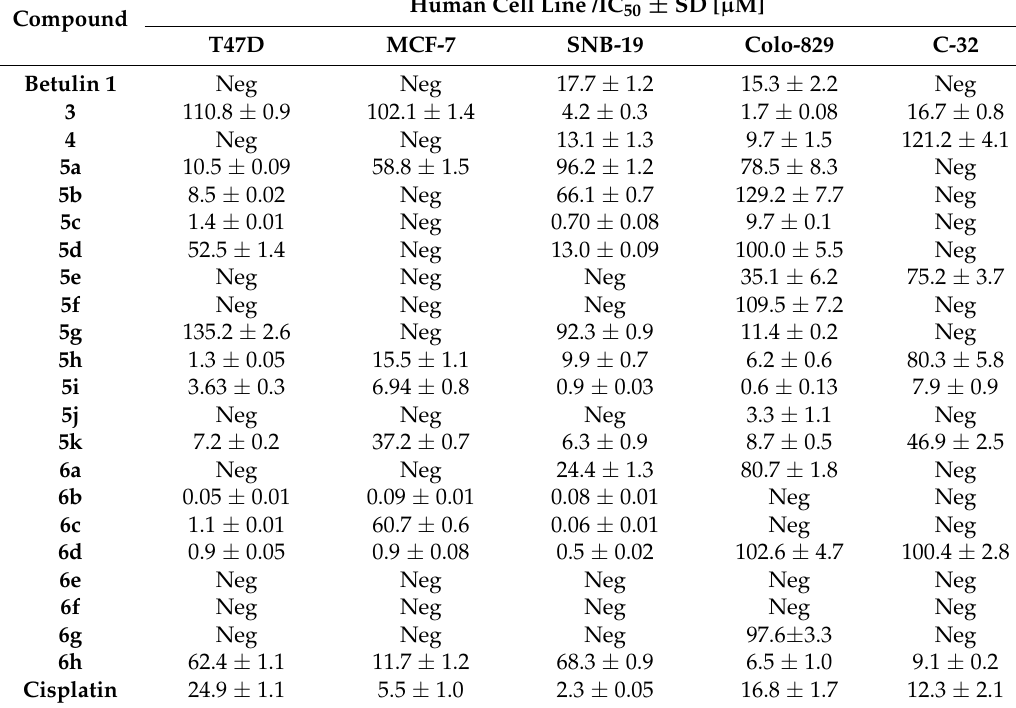
Neg—negative in the concentration